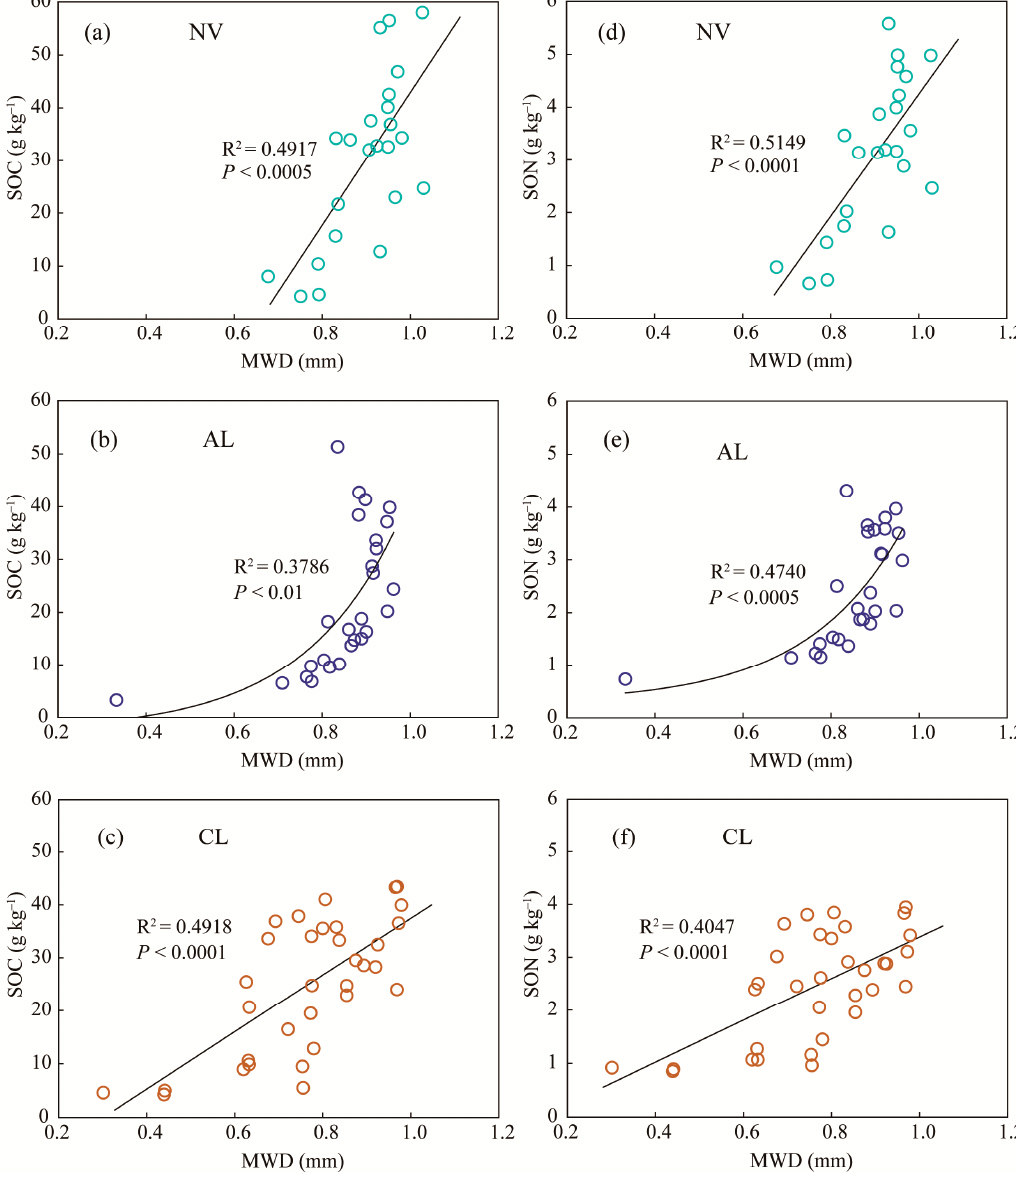
Figure 4. Relationships between MWD and SOC content in soils at all depths under native vegetation land ( a ), under abandoned cropland ( b ), and under cropland ( c ); and relationships between MWD and SON content in soils at all depths under native vegetation land ( d ), under abandoned cropland ( e ), and under cropland ( f ). NV, native vegetation land; AL, abandoned cropland; CL, cropland.